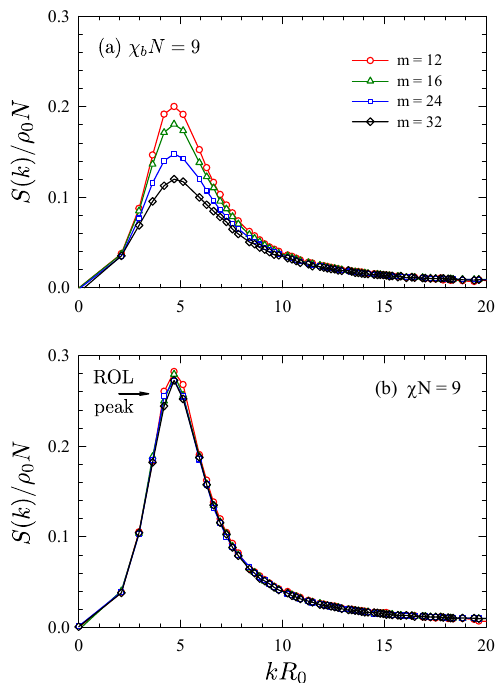
Figure 1. Structure function, S ( k ) , for symmetric diblocks of ¯ N = 10 4 obtained in a cubic simulation box of size L = 3 R 0 with different numbers of grid points, m = L / ∆ . Plot ( a ) shows results for χ b N = 9 without any calibration, while plot ( b ) shows results for χ N = 9 using the linear calibration, χ = z ∞ χ b . The arrow marks the peak height predicted by ROL theory. Reproduced from Ref. [42].